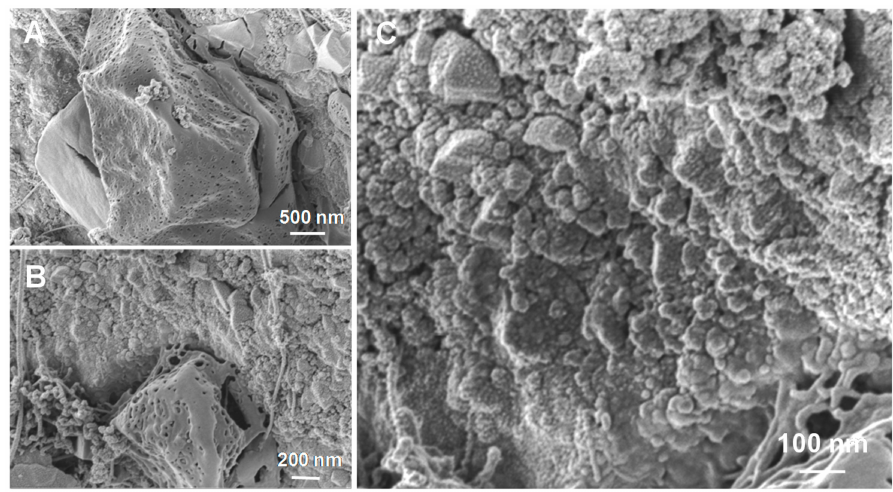
Figure 6. ( A , B ) High-resolution SEM micrographs of sulfur aggregates: from sulfur nanosized particles (i.e., 15 ± 4 nm, C ) to larger sulfur aggregates featuring with numerous voids. For higher H 2 S concentrations in the stream (1 vol.%; O 2 -to-H 2 S = 2.5, 60 ◦ C), H 2 S conversion and sulfur selectivity with NiS 2 /SiC foam are slightly reduced to 99.6% and 99.4%,